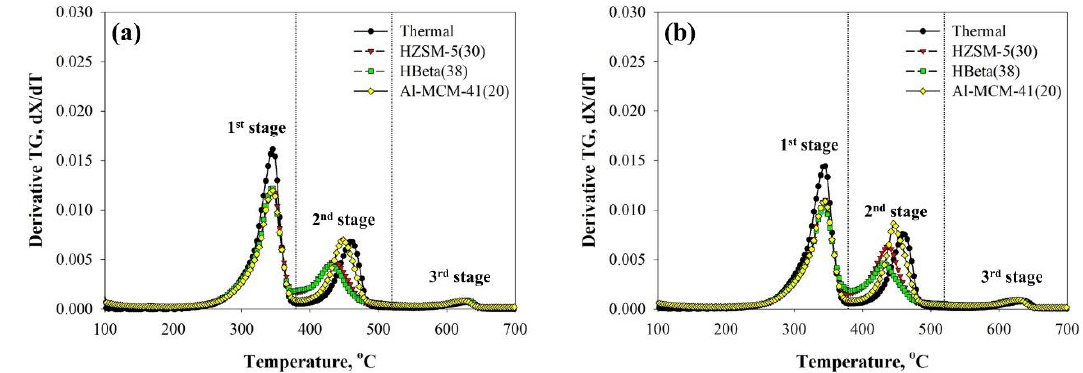
Figure 2. DTG curves of ( a ) TP-1 and ( b ) TP-2 obtained from their thermal and catalytic pyrolysis at 10 °C/min.